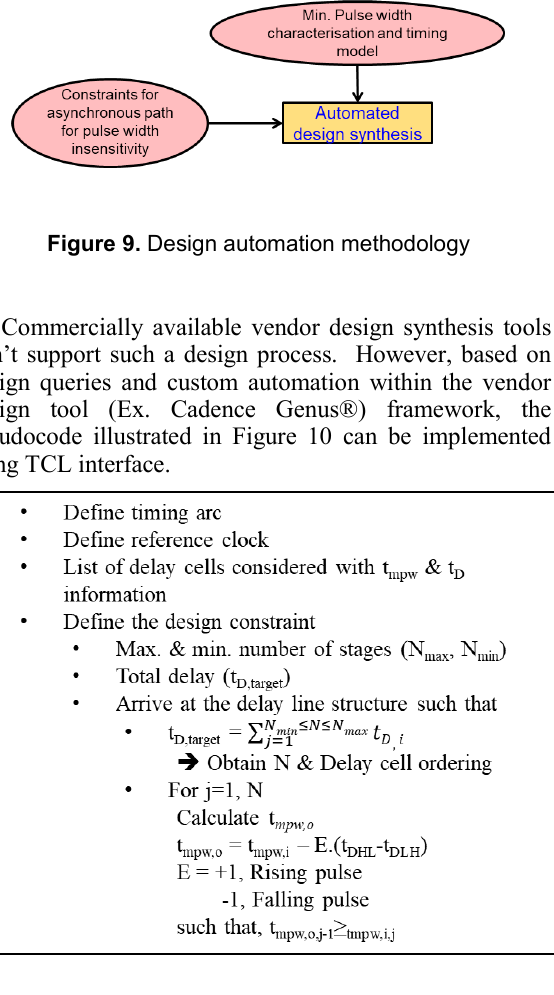
Figure 10 . Custom synthesis pseudocode